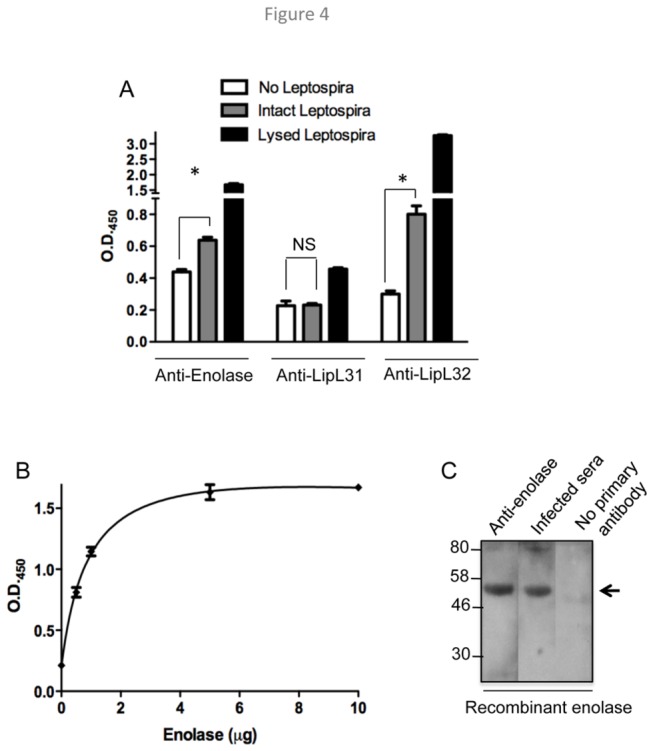
Enolase can be detected on L. interrogans surfaceand specifically interacts with outer membrane proteins.(A) Detection of enolase on the surface of intact L. interrogans. Microtiter plates were coated in the absence or presence of intact or lysed L. interrogans (109/ml) and incubated with enolase antibody. Bound antibody was detected using HRP-labeled secondary antibodies and TMB substrate for color development, which was recorded at A
450. A known surface-exposed and outer membrane protein, LipL32, and a subsurface inner membrane protein, LipL31, were used as controls. (B) Interaction of enolase with OM proteins. A fixed amount (1µg) of solubilized proteins from isolated OM vesicles were coated on microtiter plates and assessed for binding with increasing amount of recombinant enolase, as described in panel B. The binding of enolase to immobilized OM proteins reached saturation at 5 µg, as there is a significant increase (P < 0.001) in individual OD values between 0-5 µg, while the difference between 5 and 10 µg values is nonsignificant (P > 0.05). (C) Recognition of recombinant enolase by infected hamster serum as assessed by immunoblotting. Recombinant enolase was probed with antibodies produced in immunized mice or antiserum collected from hamster infected with L. interrogans. The arrow indicates the position of enolase. Migration of protein standards is shown to the left.